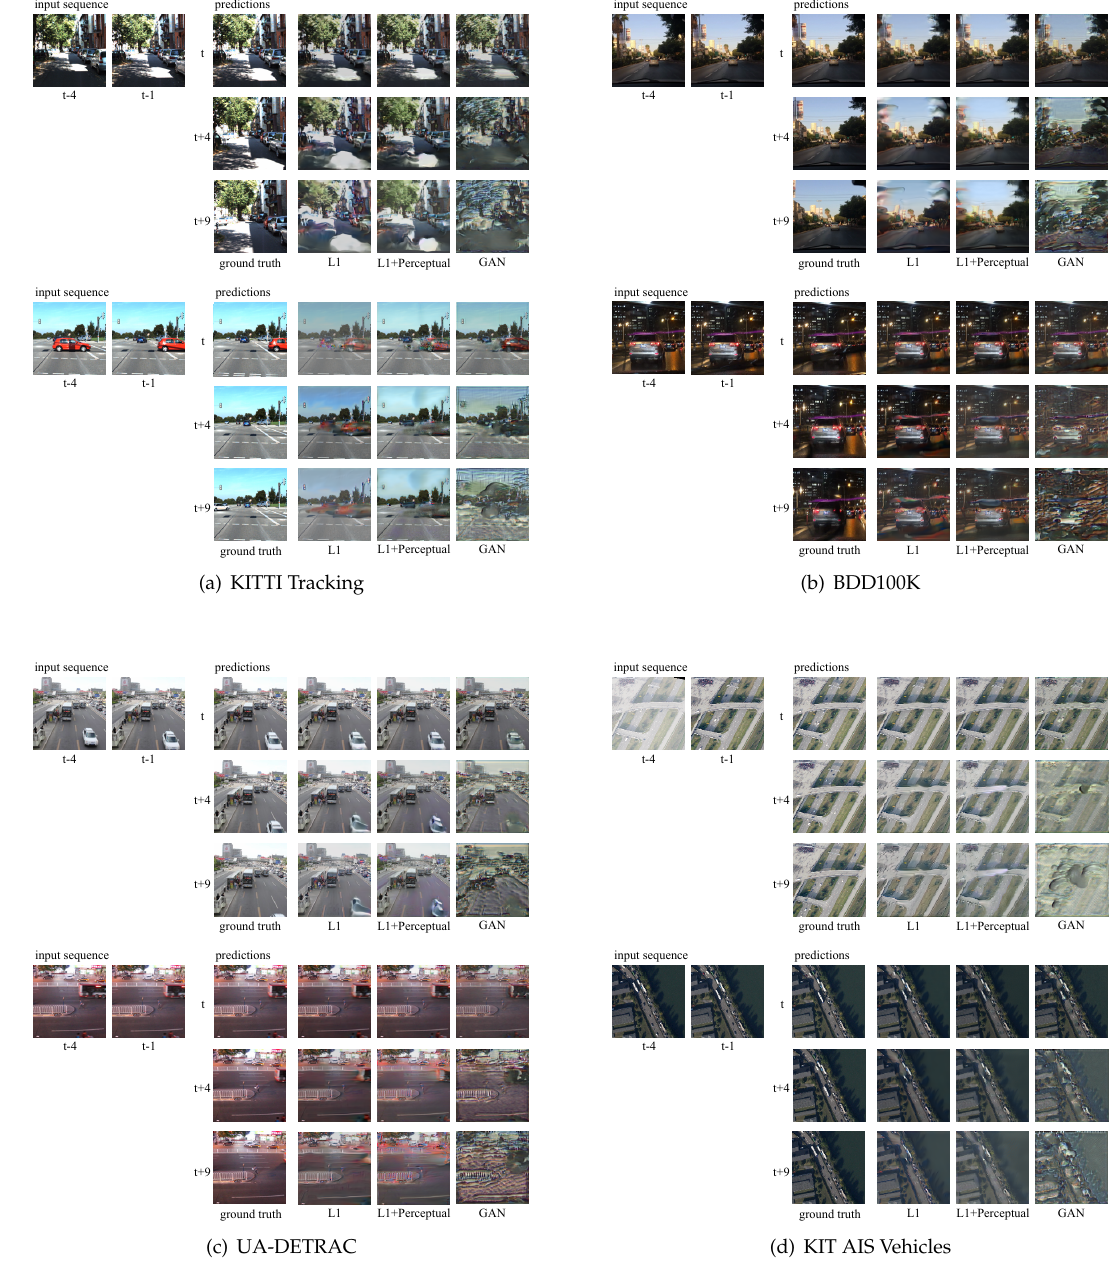
Figure 4. Qualitative test results of three selected models for all evaluation datasets. To generate these images, we used the models that were trained on Cityscapes for 20 epochs. The models were trained to predict the next frame based on four past frames. The qualitative results of all loss combinations can be found in Appendix B. The videos for this figure are included in the supplementary material. (The images are best viewed on